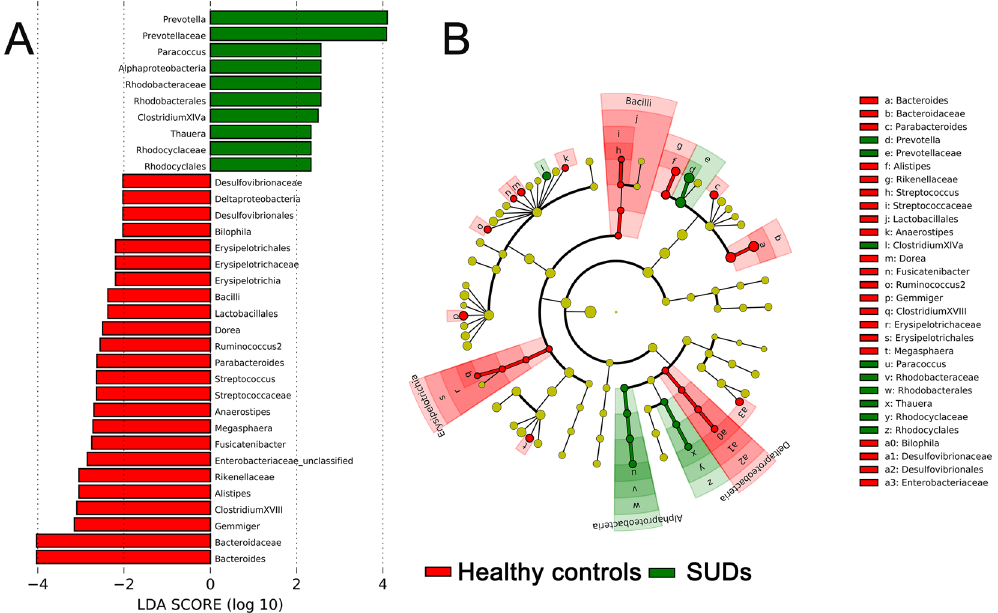
Figure 4. Taxonomic biomarkers. ( A ) Linear discriminative analysis (LDA) effect size LEfSe analysis between the HCs (red) and SUDs (green). ( B ) Cardiogram showing differentially abundant taxonomic clades with an LDA score > 2.0 among cases and controls, p <